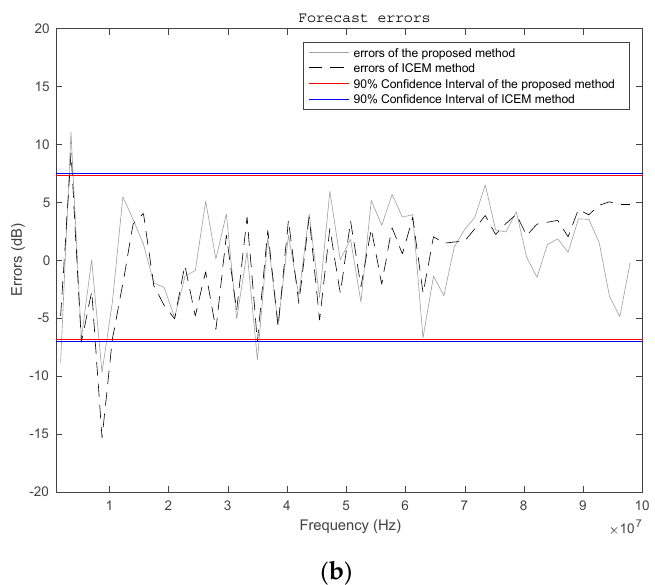
Figure 22. Comparison between the proposed method and ICEM method for Board 1. ( a ) Predicted results; ( b ) forecast errors.